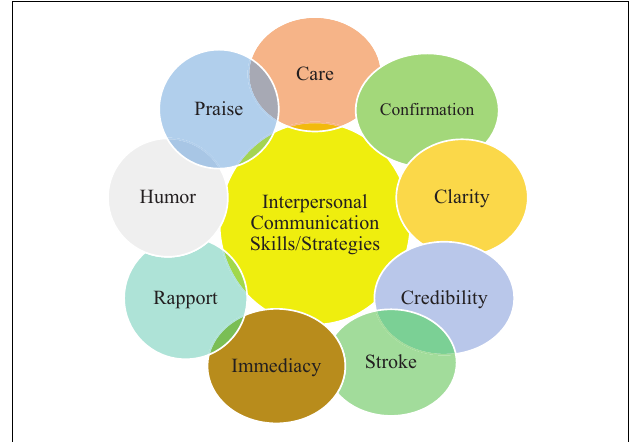
FIGURE 1 | Interpersonal communication